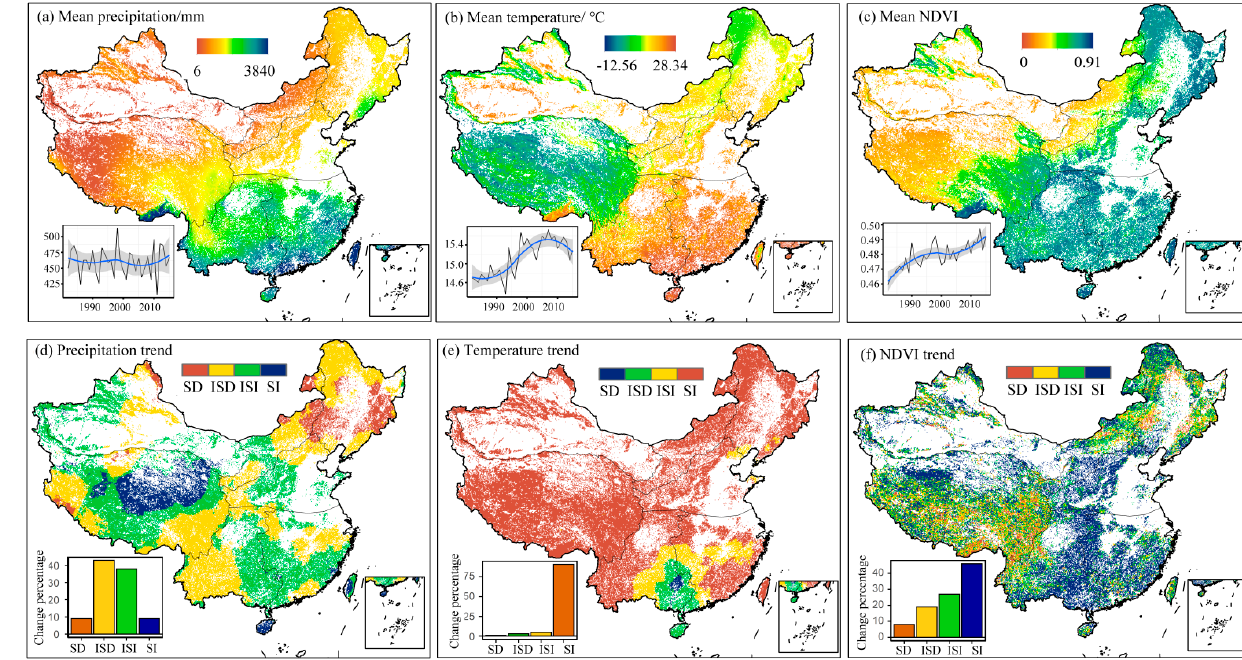
Figure 6. The mean and trends of precipitation ( a , d ), temperature ( b , e ), and the Normalized Difference Vegetation Index (NDVI; ( c , f )) during the growing season in China (SD—Significant decrease trend; ISD—Insignificant decrease trend; ISI—Insignificant increase trend; SI—Significant increase trend)).